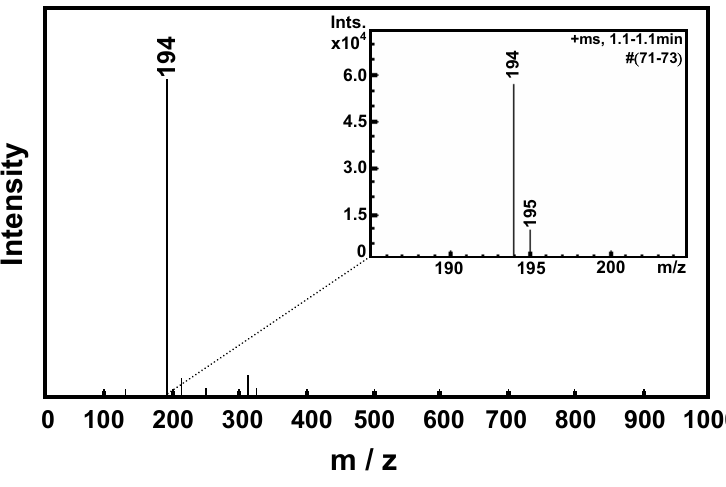
Figure 3. Mass spectrum of BM1